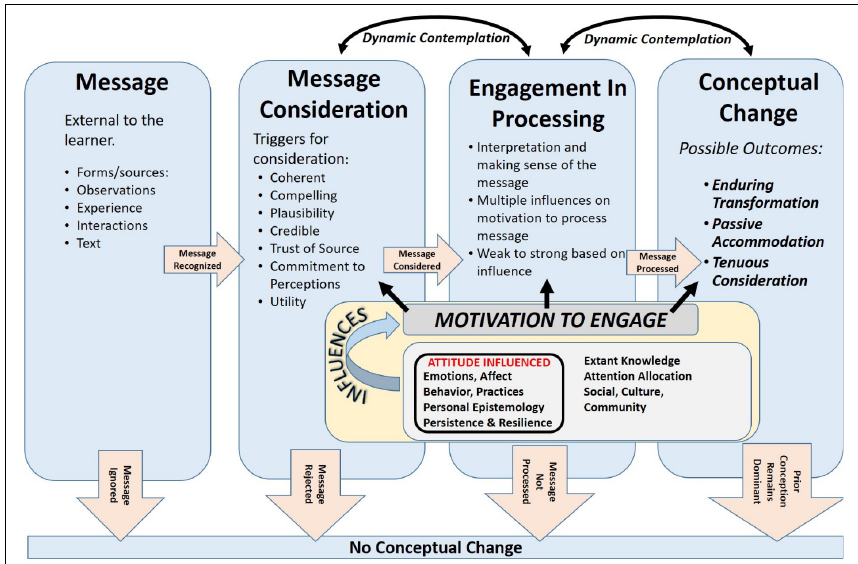
Figure 1 : The Dynamic Model of Conceptual Change or